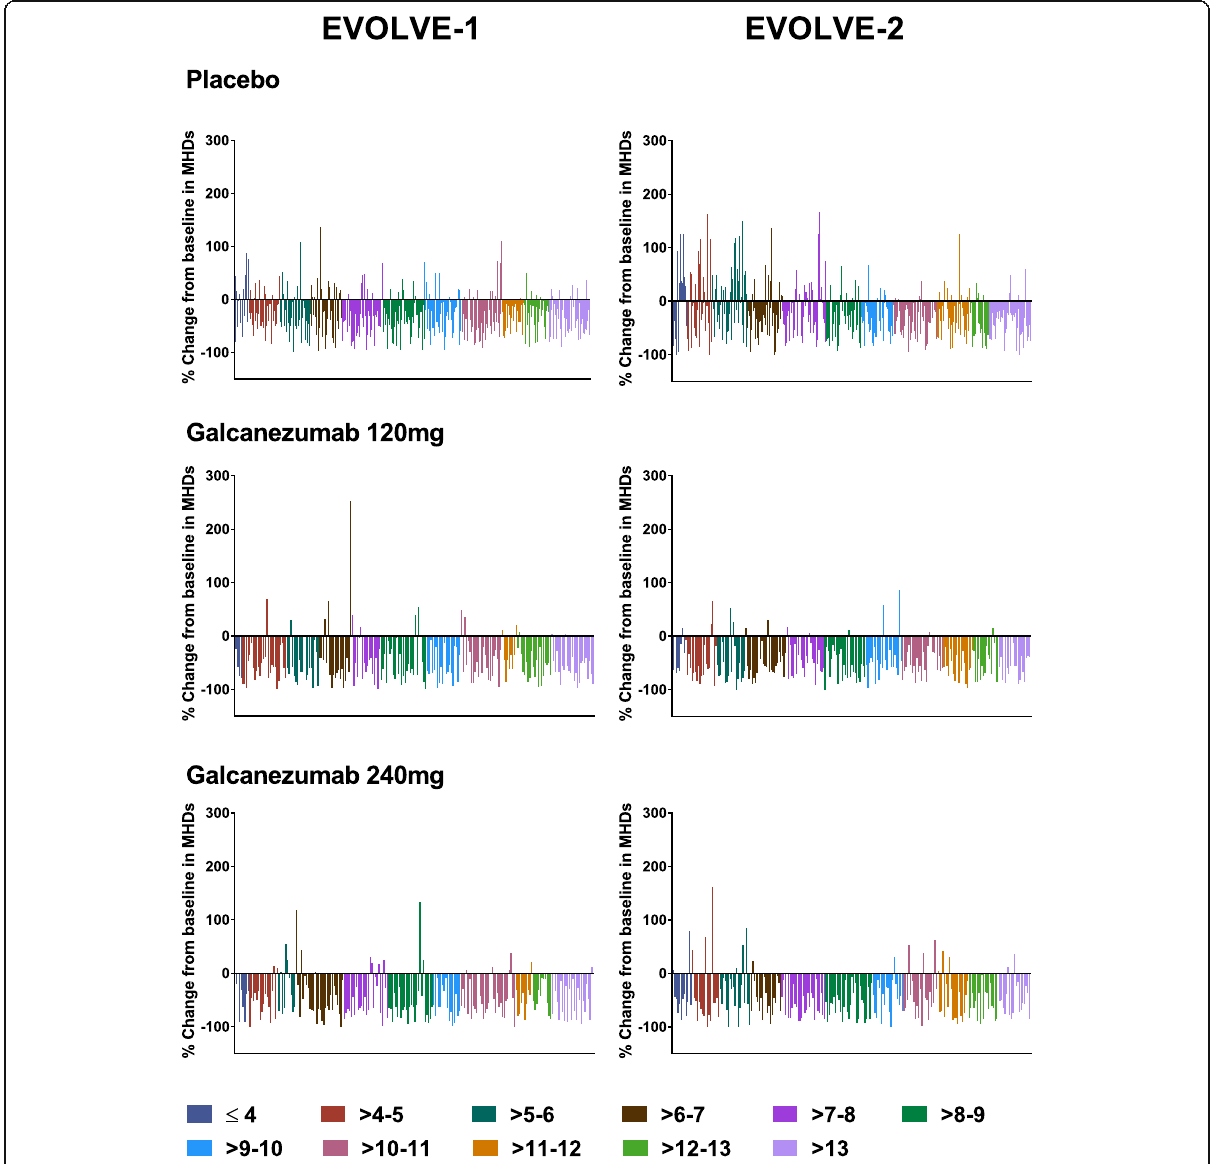
Fig. 5 Waterfall plots showing the percent change from baseline in number of MHDs of Month 1 to 6 by baseline number of migraine headache